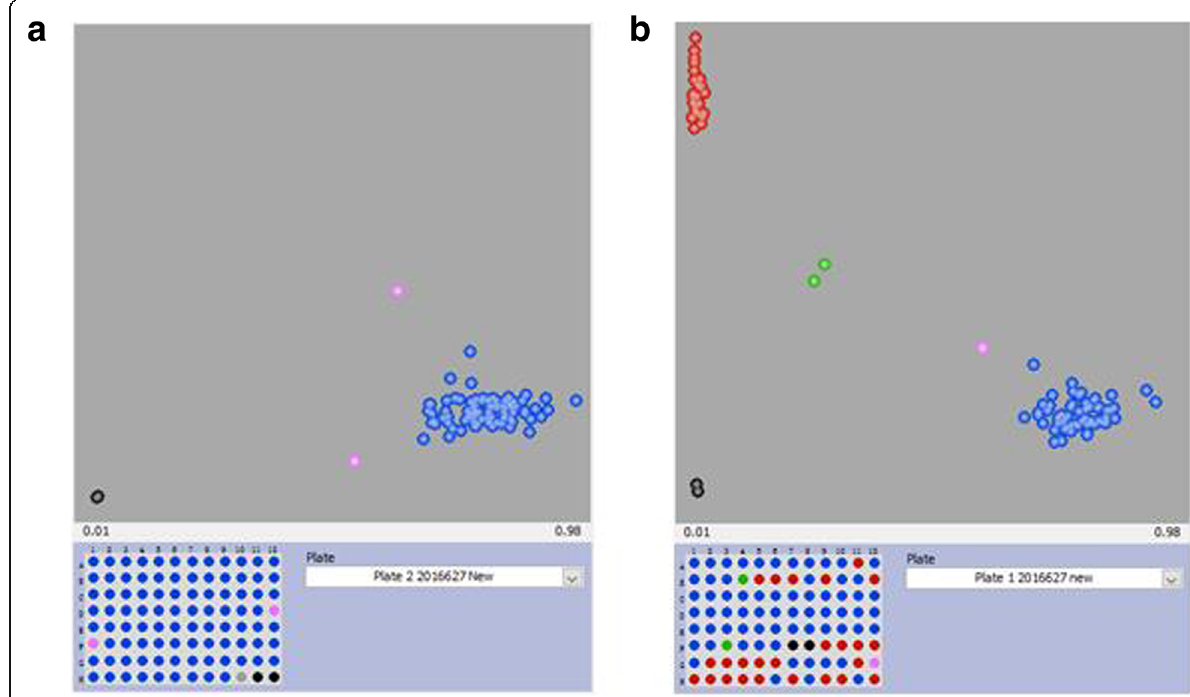
Fig. 1 Valid and invalid markers. a invalid markers generate one fluorescent signal; b valid markers generate at least t effective fluorescent signals